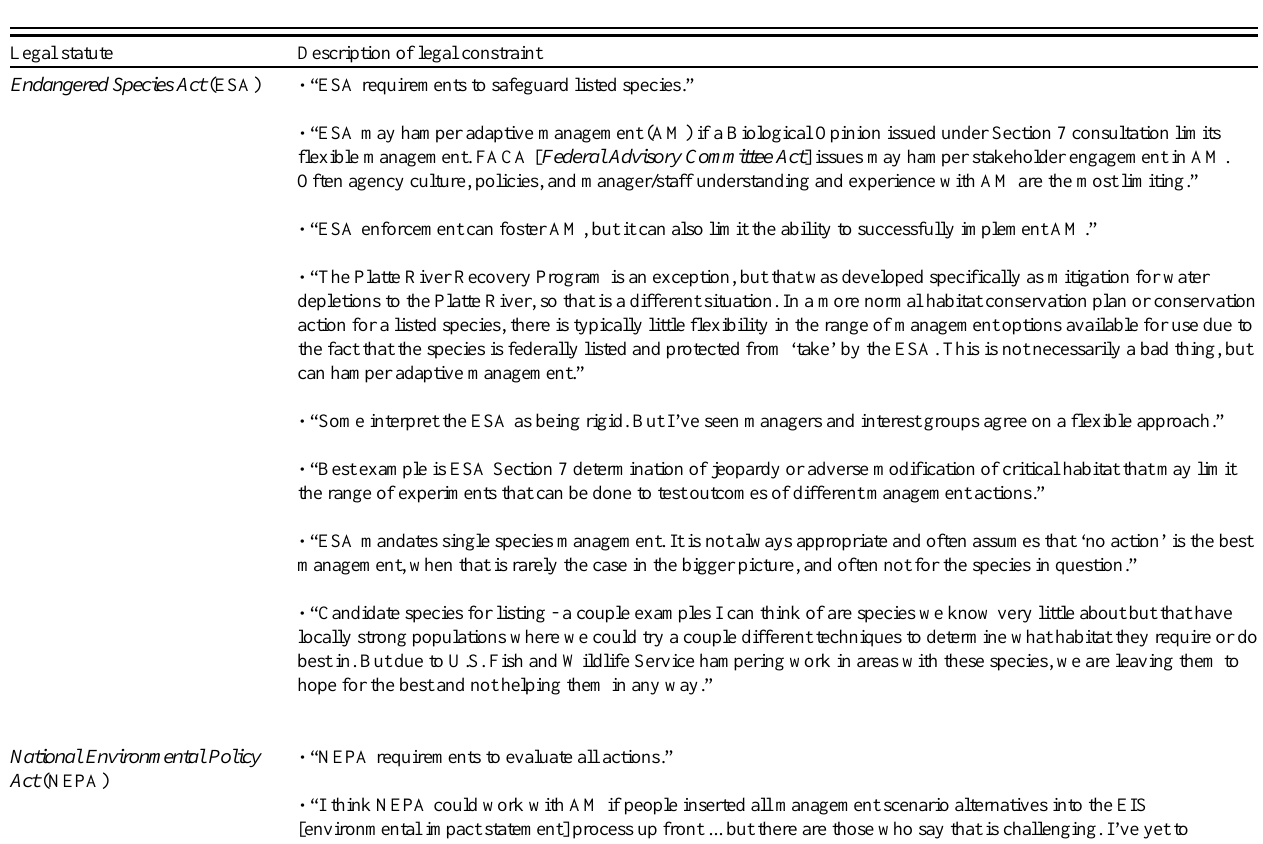
Table 1. Specific examples of legal constraints provided by